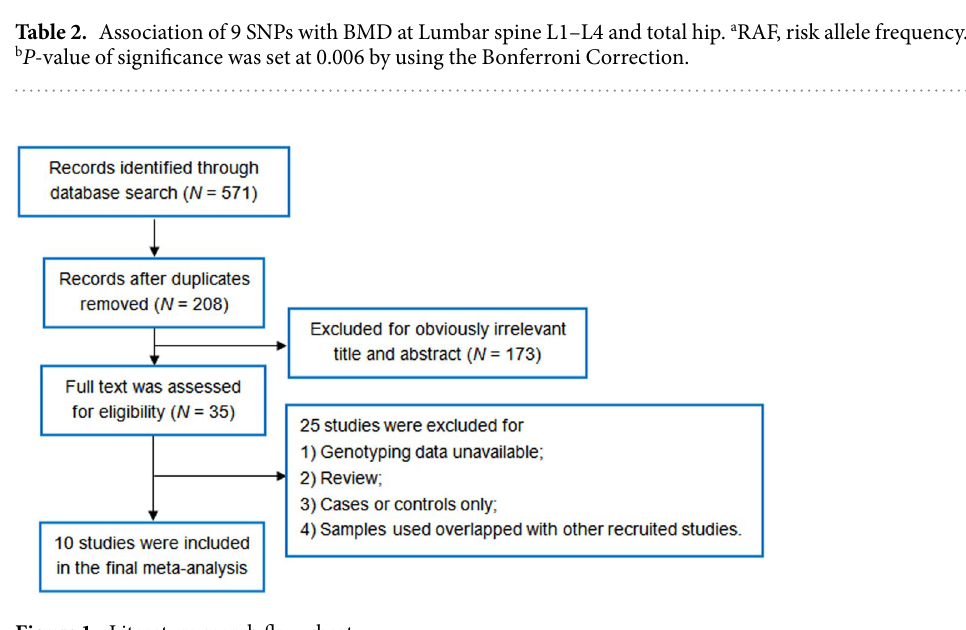
Figure 1. Literature search flow